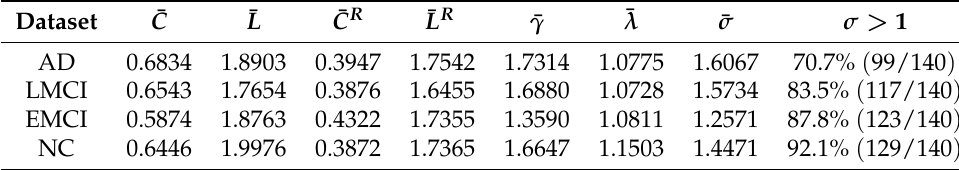
Table 3. Average small world results.